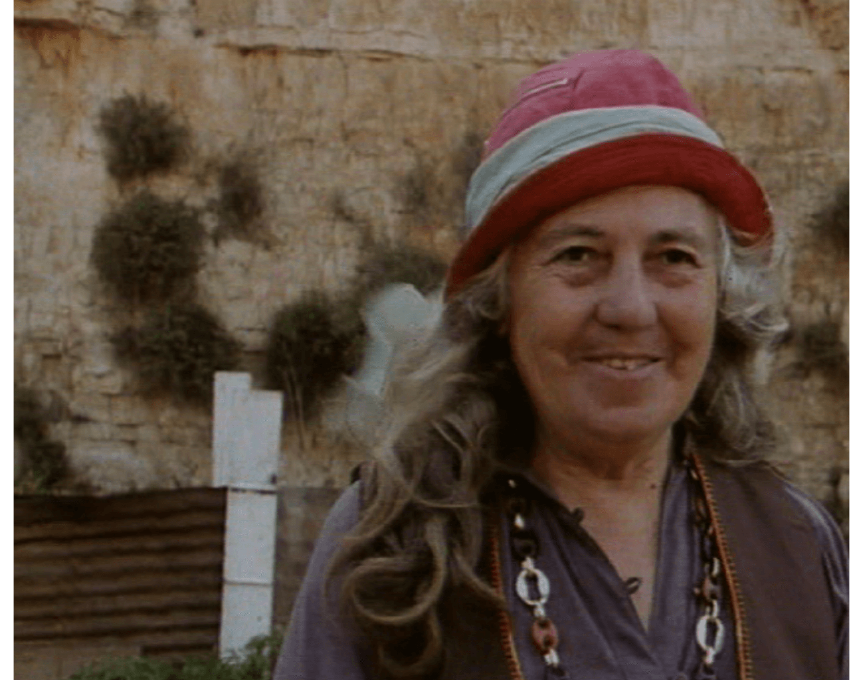
Figure 11 : Miriam, Source: Wadi, 10 Years Later , Amos Gitai,